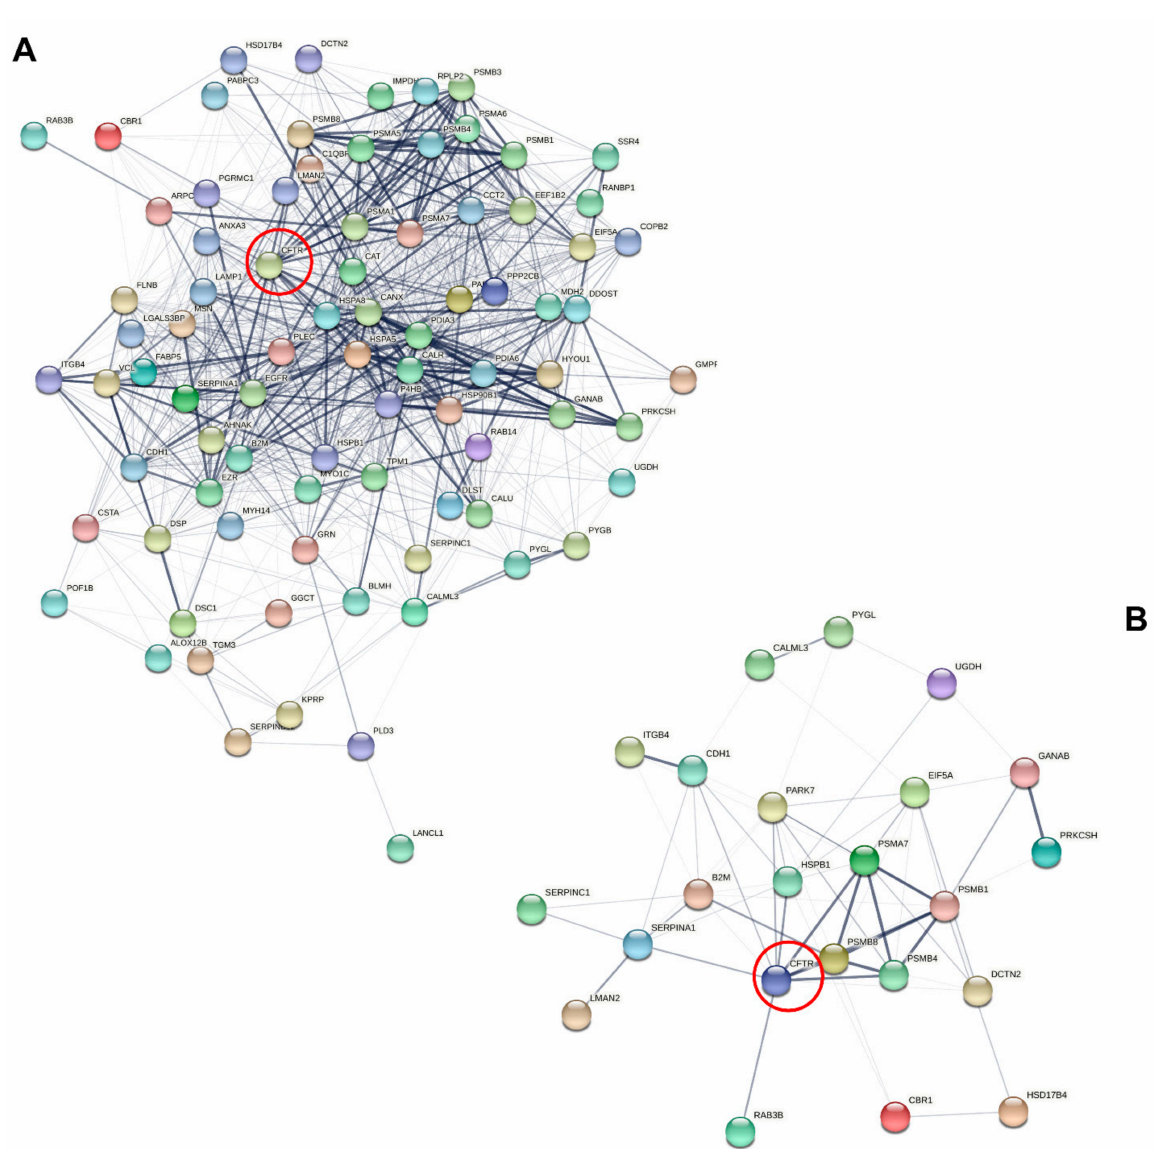
Figure 6. Interaction network mapping of the CFTR interactome and F508del CFTR interactome of sweat CF biomarkers. ( A ) Sweat CFTR interactors in CF-specific abundance (82/82 mapped proteins). ( B ) Sweat F508del CFTR interactors in CF-specific abundance (22/23 mapped proteins). Network settings included: Homo sapiens database, lowest confidence minimum required interaction score, hidden disconnected nodes, and confidence-based networking. CFTR was added to the list of sweat proteins of interest before analysis (red